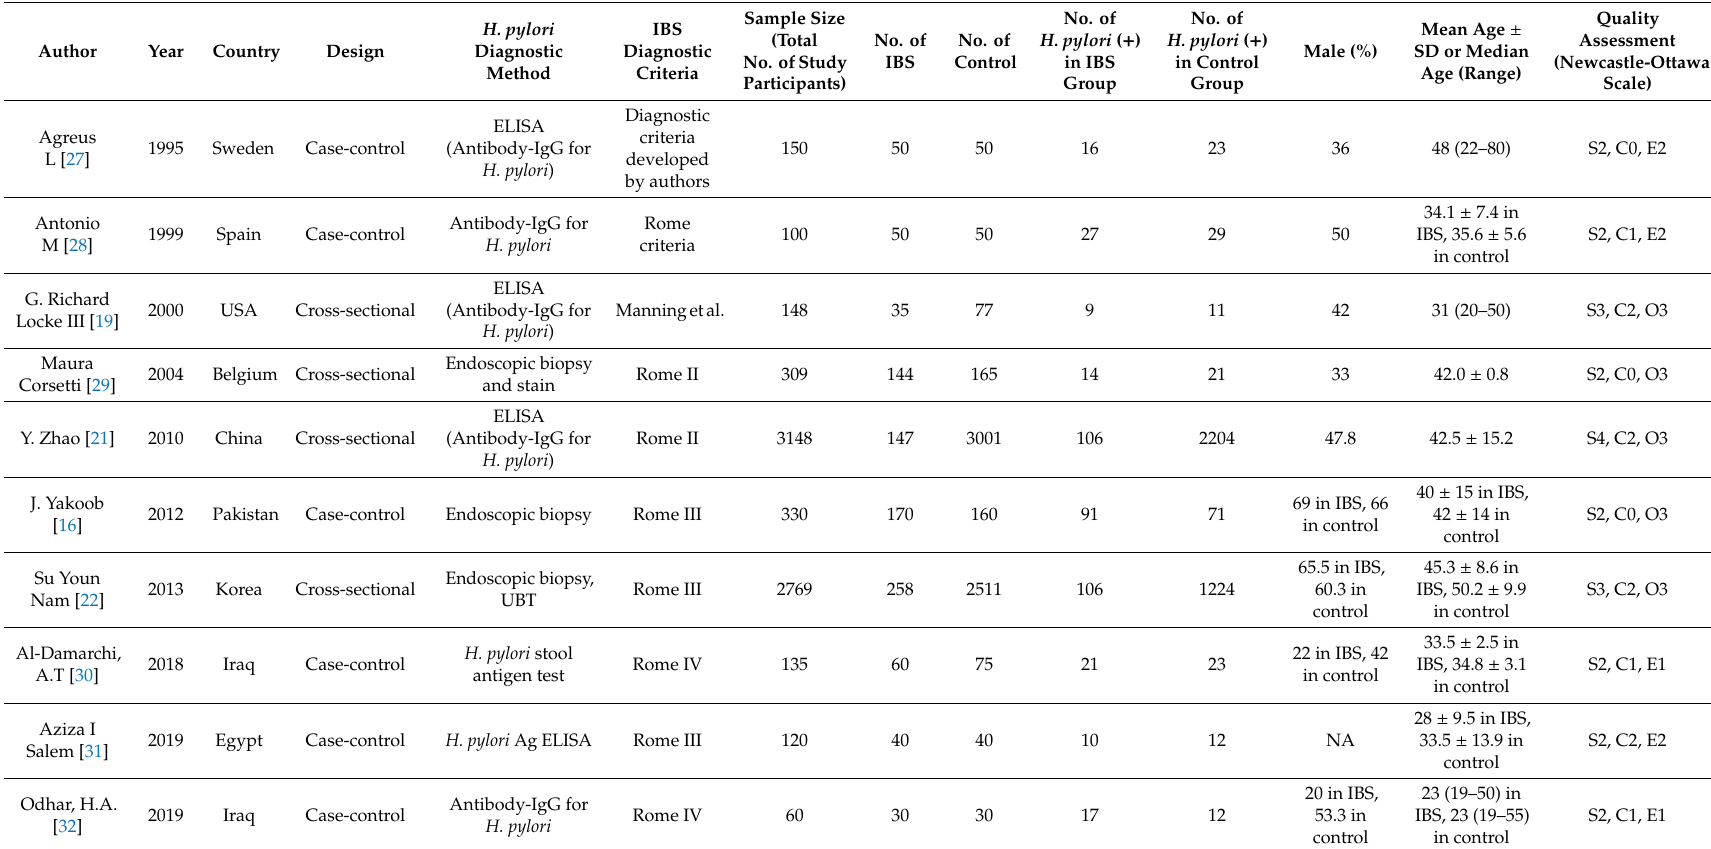
Table 1. Characteristics of the studies included in